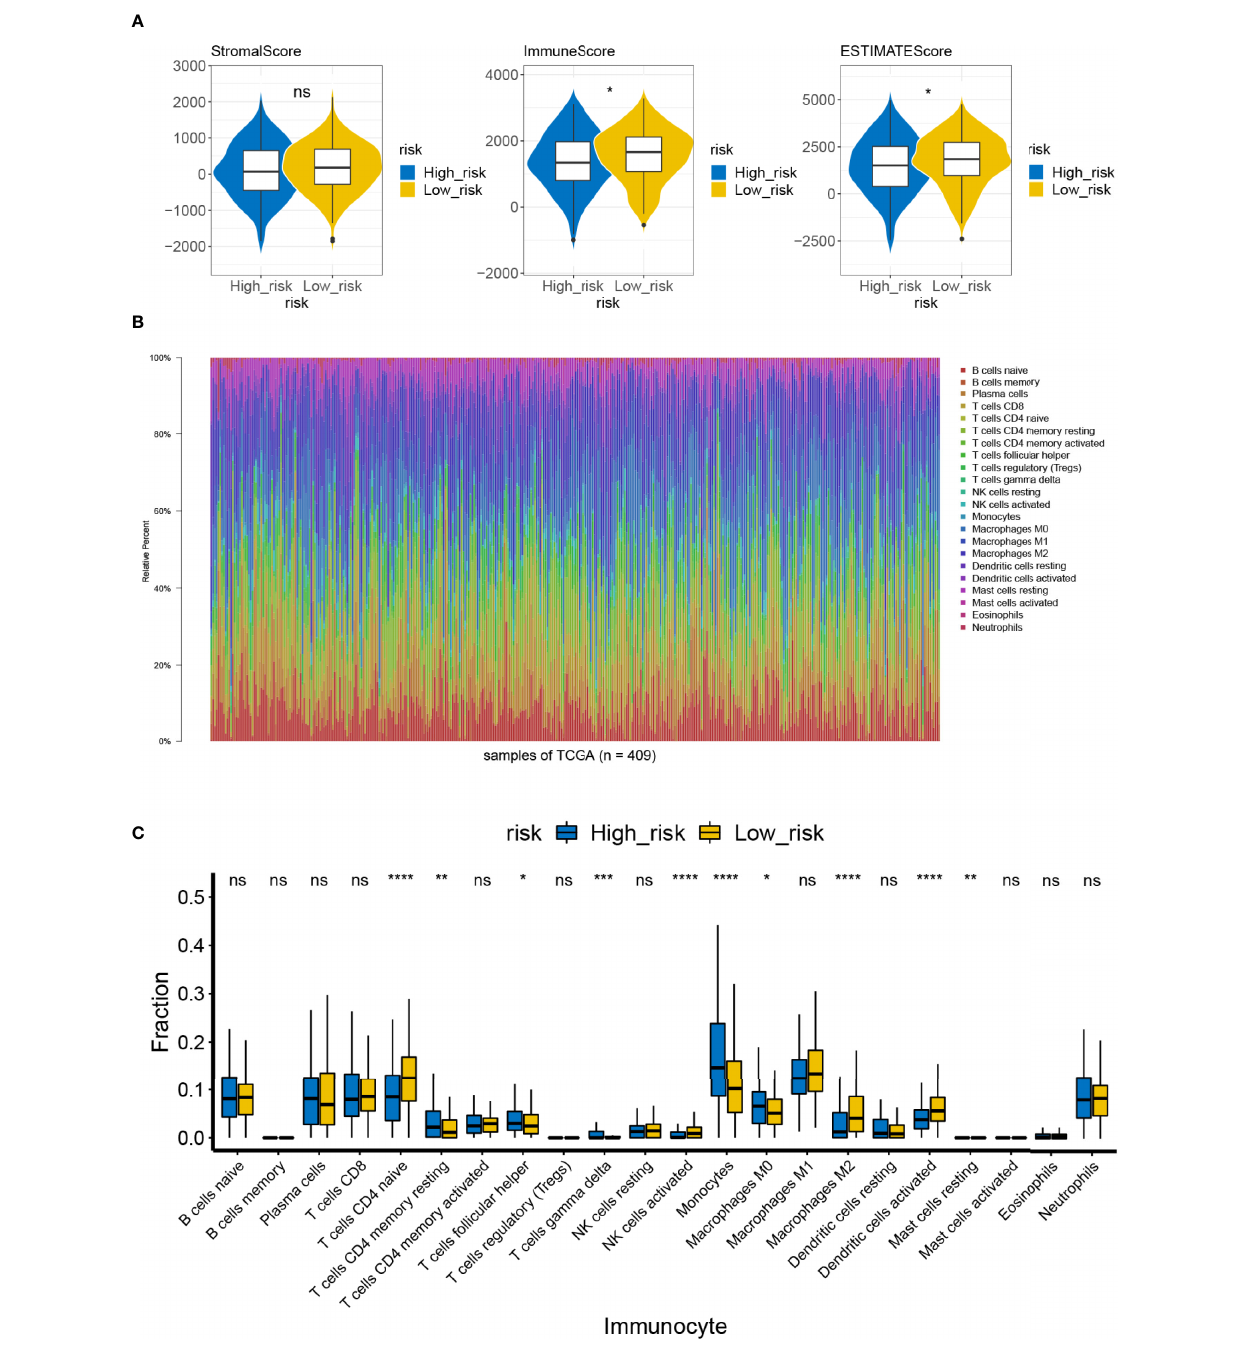
FIGURE 9 | Difference in immune in fi ltration and microenvironment between the high- and low-risk groups. (A) The immune microenvironment of the high-/low-risk groups was analyzed by ESTIMATE, and the immune score and the ESTIMATE score of the high-/low-risk groups were lower ns, not signi fi cant. (B) Abundance ratio of immune cells in the 446 LUAD cases. Each column represents a sample, and each column with a different color and height indicates the abundance ratios of immune cells in this sample. (C) A rank-sum test was performed to analyze the difference in the immune cells between the high- and low-risk groups. Signi fi cant differences were noted in the 10 immune cells between the high- and low-risk groups; T-cells CD4 naive, activated NK cells, M2 macrophages, and activated dendritic cells in the high-risk groups showed lower immunological in fi ltrations. ns, not signi fi cant. *P<0.05, **P<0.01, ***P<0.001,